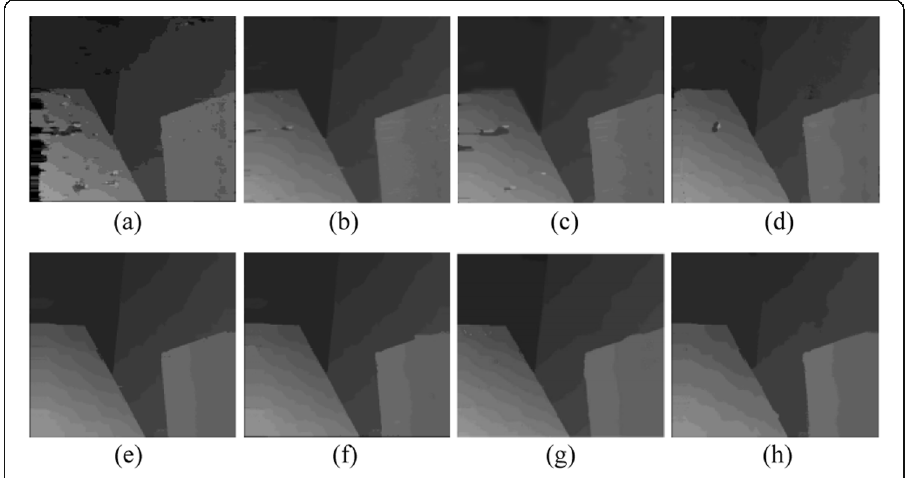
Fig. 18 Estimated disparity maps of Venus achieved by a Kuo et al. [27], b Kuo [28], c Hsieh [29], d Sun [31], e ASW [21], f S-ASW [23], g LF-SM [36], and h the proposed